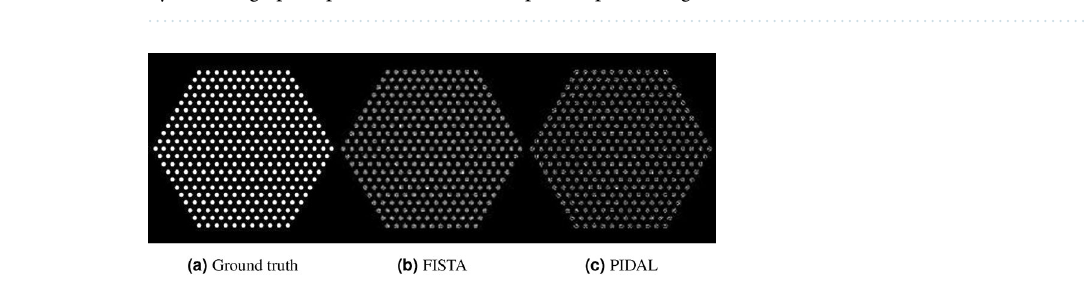
Figure 7. Activity distribution based on the inverse approach. The pin activity was estimated from each image by summing up the pixel values inside the present pins. The ground truth is shown as the red line.